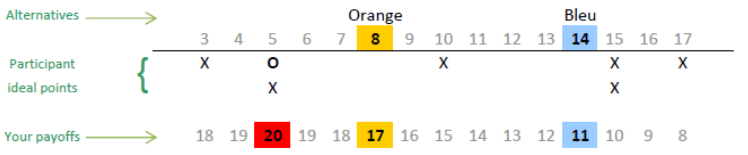
Figure A1. Example–Alternatives and ideal positions.